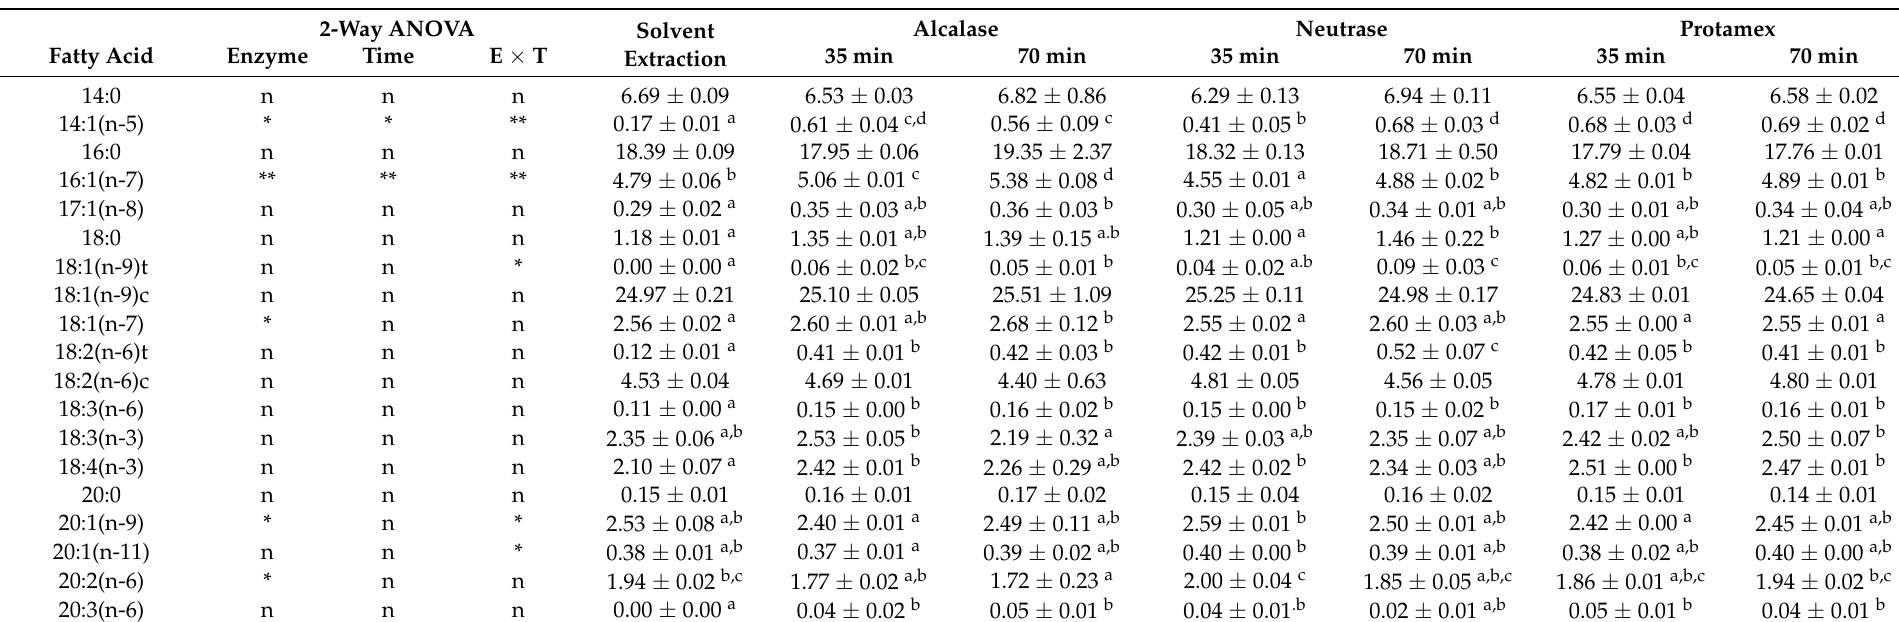
Table 3. Fatty acid composition of enzymatically extracted oils and solvent-extracted oil (reference) from Baltic herring by-products. The values are presented as mass percentages of the total fatty acid content. The results are shown as mean value ± standard deviation of the three analytical